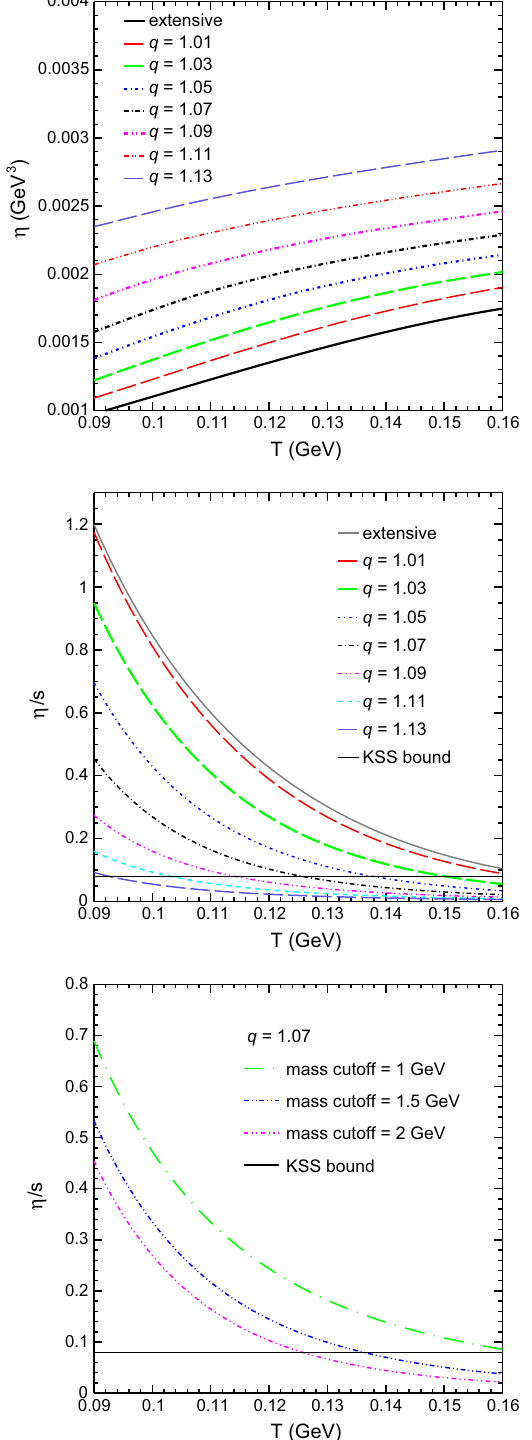
Fig. 3 Top panel shows the variations of shear viscosity ( η ) as a func- tion of temperature for different q -values. Middle panel shows η/ s ver- sus temperature for different q -values. Lower panel presents the varia- tions of η/ s with respect to temperature at q = 1 . 07 for various upper mass cutoff of hadron resonance gas